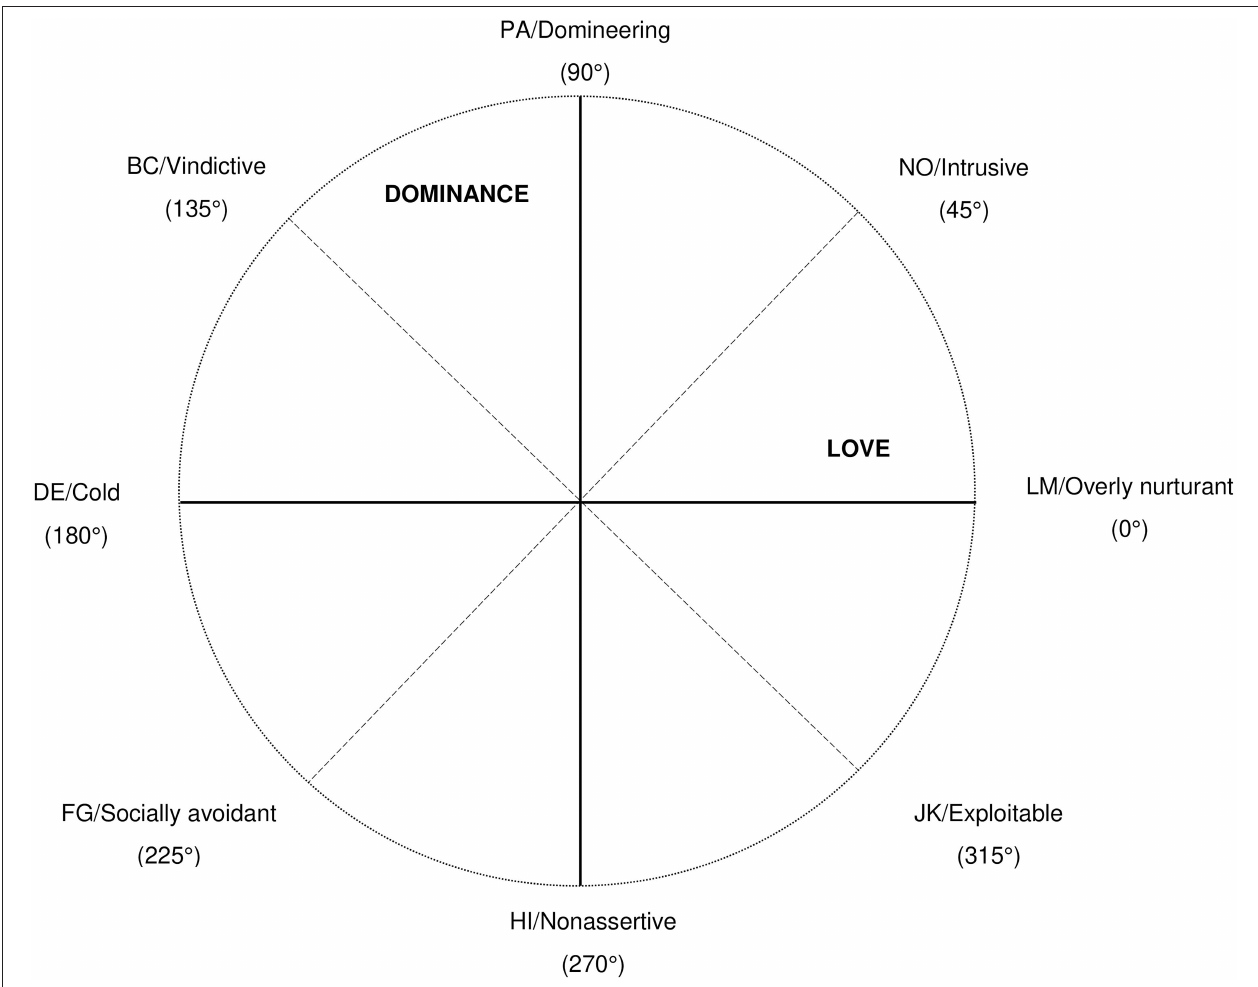
FIGURE 1 | Circumplex structure and scales of the inventory of interpersonal problems (see also Gurtman,